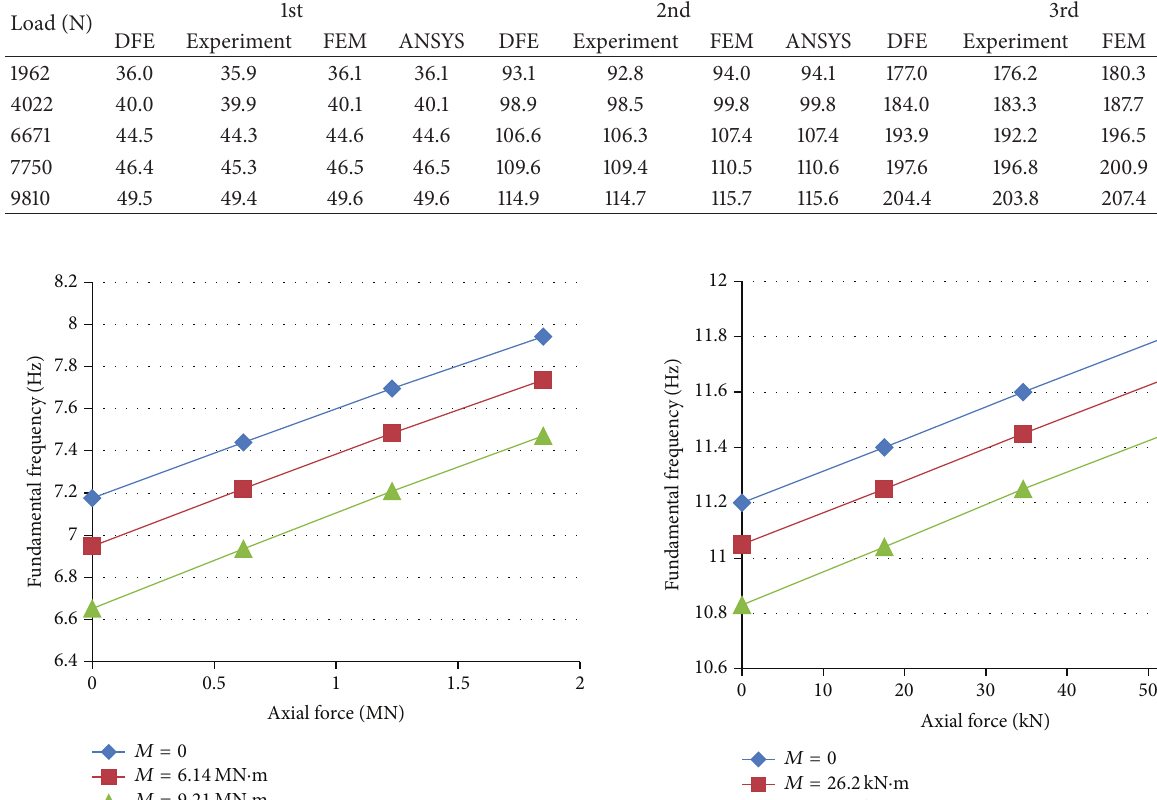
Table 7: The first three bending natural frequencies (Hz) of the clamped-clamped aluminium beam for various axial loads: 1-element DFE, 5-element FEM, and ANSYS models.